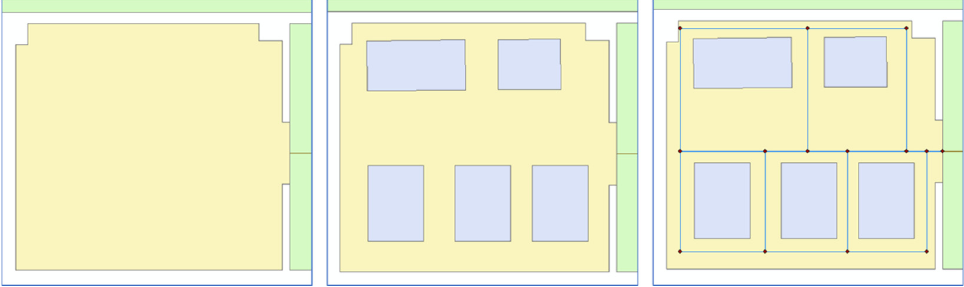
Figure 17. Generating a Level 4 network for a room with furniture using SMAT.